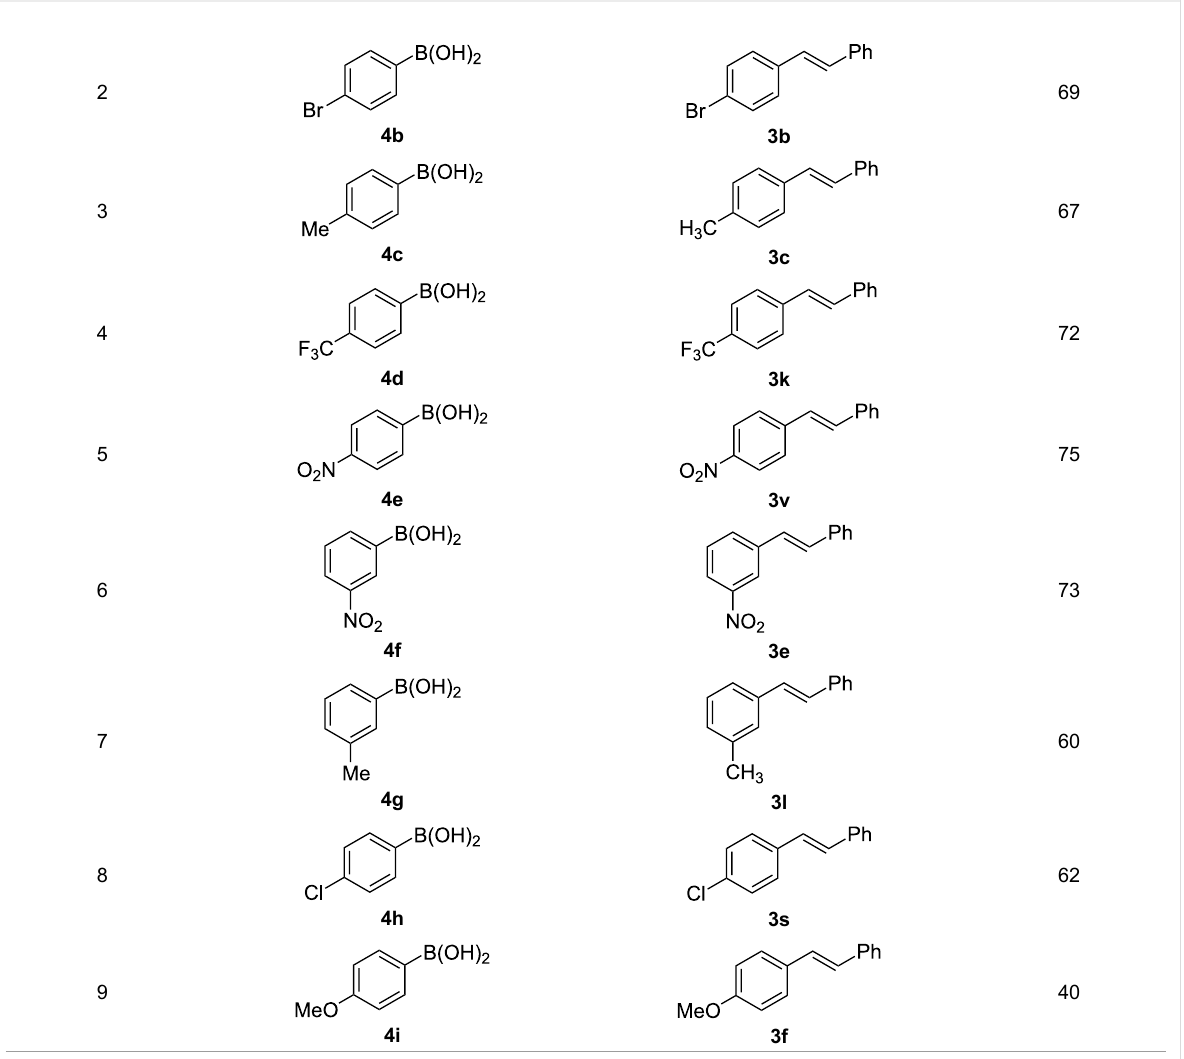
Table 5: Substrate scope in Heck arylation reaction of phenylboronic acids with olefins. a